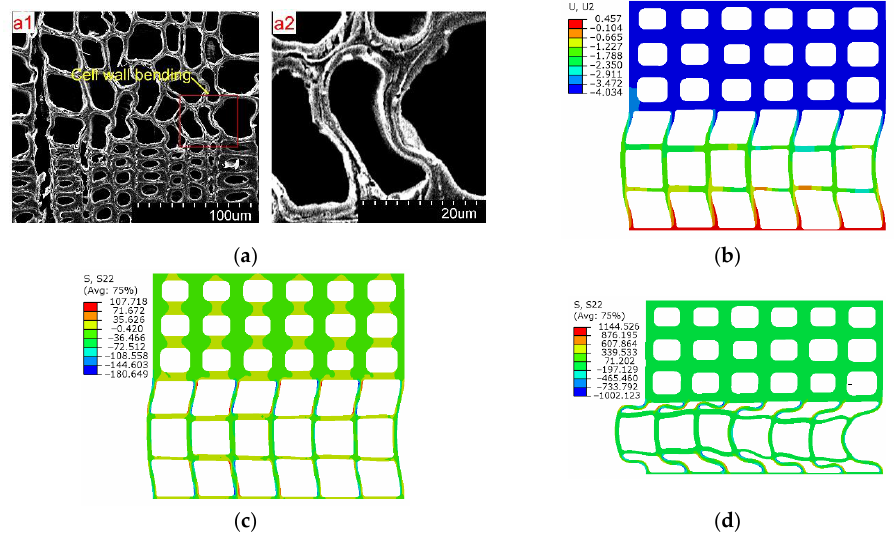
Figure 9. The deformation mode and stress distribution of cell network and SEM picture: ( a1 ) SEM of cell deformation; ( a2 ) bending or buckling of the earlywood cell wall; ( b ) deformation mode of the FE model at yield point; ( c ) Normal stress in the radial direction at yield point; ( d ) Normal stress in the radial direction at larger deformation. The stress – strain curves for the simulated and tested specimens are displayed in Fig- ure 10, where the simulation results are presented in the form of an expected region area.